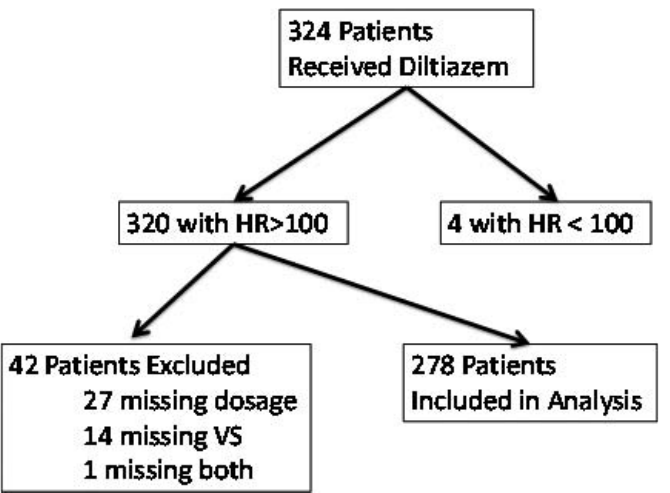
Figure 1. Study demographics. HR , heart rate.